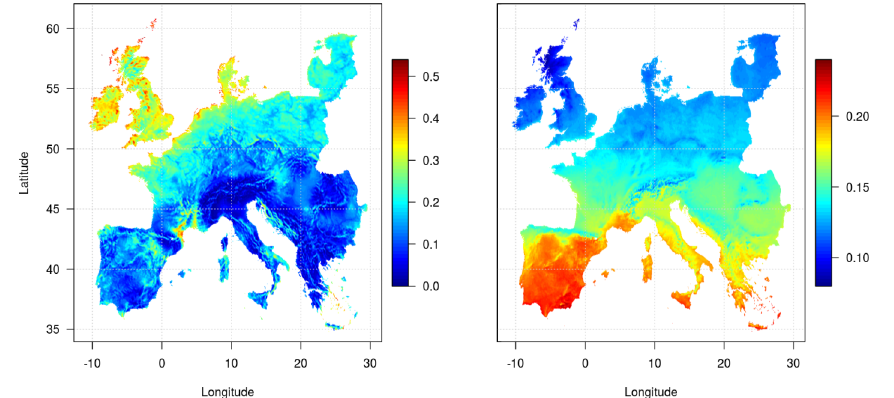
Figure 2. Average capacity factors for wind (left) and photovoltaics (right) in Europe (1995–2015) derived from the regional reanalysis COSMO-REA6 and the satellite-based SARAH 2 dataset.